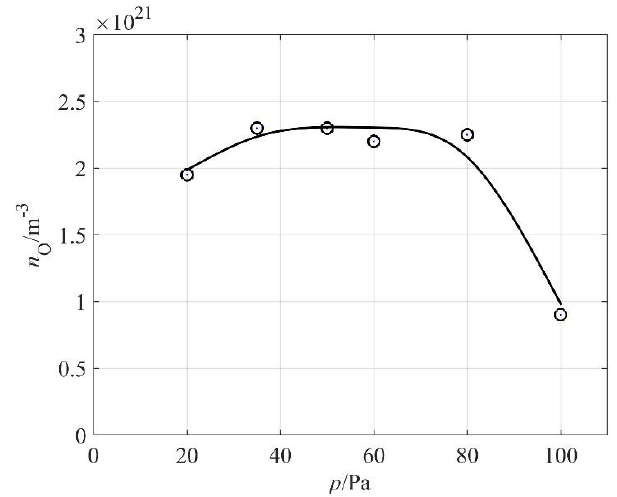
Figure 7. The O-atom density versus pressure at duty cycle 70%.